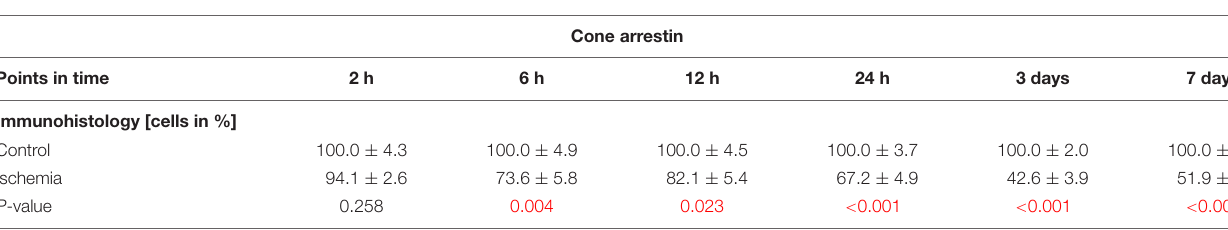
TABLE 8B | Analyses of the cone arrestin staining (%) at all points in